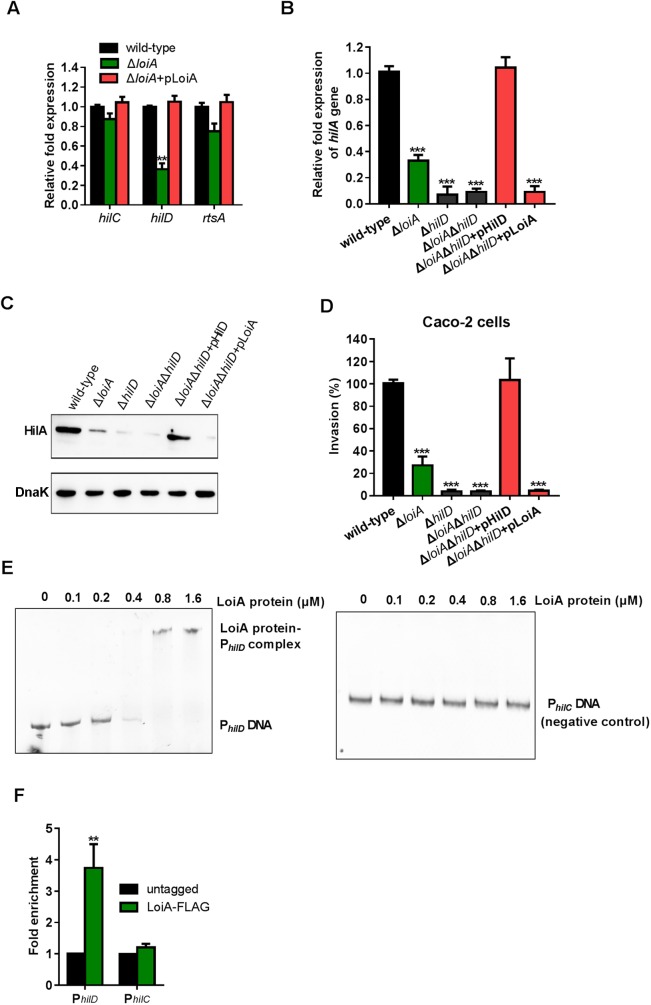
LoiA regulates hilA and other SPI-1 genes through HilD.(A) qRT-PCR analysis of changes in the expression of three direct higher regulators of hilA (hilD, hilC, and rtsA) in wild-type, ΔloiA and ΔloiA+pLoiA. Strains were grown under SPI-1-inducing conditions. (B) qRT-PCR analysis of changes in hilA expression in wild-type, ΔloiA, ΔhilD, ΔloiAΔhilD, ΔloiAΔhilD+pHilD and ΔloiAΔhilD+pLoiA. Strains were grown under SPI-1-inducing conditions. (C) Western blot analysis of HilA in wild-type, ΔloiA, ΔhilD, ΔloiAΔhilD, ΔloiAΔhilD+pHilD and ΔloiAΔhilD+pLoiA. Strains were grown under SPI-1-inducing conditions. Expression of the tagged HilA protein was determined using that of DnaK as the internal control. (D) Invasion assays of wild-type, ΔloiA, ΔhilD, ΔloiAΔhilD, ΔloiAΔhilD+pHilD and ΔloiAΔhilD+pLoiA. Caco-2 cells were infected with bacteria at an MOI of 10. The invasion ability of mutants is reported as percentages relative to the wild-type strain. (E) EMSAs of hilD promoter DNA fragment with purified LoiA-His6 protein (0, 0.1, 0.2, 0.4, 0.8 and 1.6 μM). hilC promoter is used as a negative control. (F) Fold enrichment of the hilD promoter in ChIP samples, as measured via ChIP-qPCR. hilC promoter is used as negative control. ΔloiA, loiA mutant; ΔloiA +pLoiA, ΔloiA complemented strain; ΔhilD, hilD mutant; ΔloiAΔhilD, loiA/hilD double mutant; ΔloiAΔhilD+pHilD, loiA/hilD double mutant complemented with HilD; ΔloiAΔhilD+pLoiA, loiA/hilD double mutant complemented with LoiA. Data are representative of at least three independent experiments and are presented as mean ±SD. P values were determined by student’s t test (**P<0.01; ***
P<0.001).